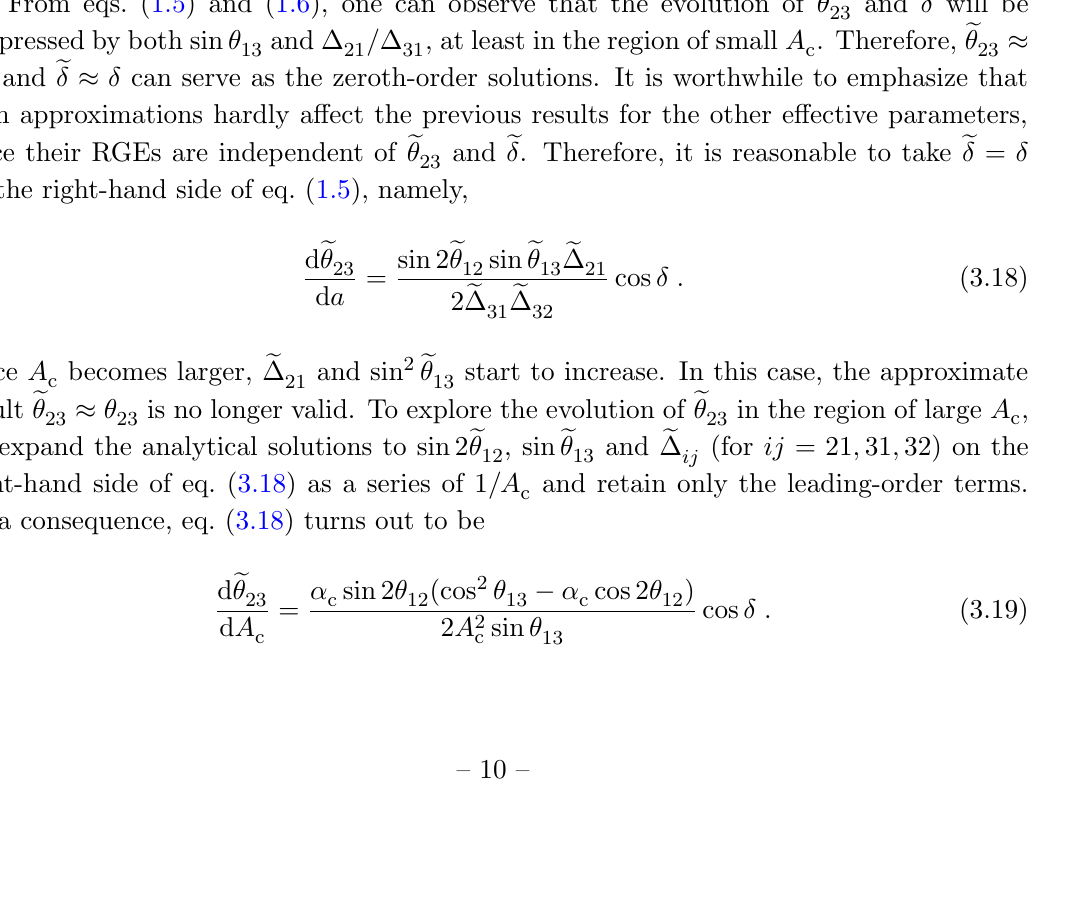
Figure 3 . Analytical and numerical solutions to e (cid:1) the case of normal neutrino mass ordering, where the input parameters and the conventions for the curves are the same as in the previous